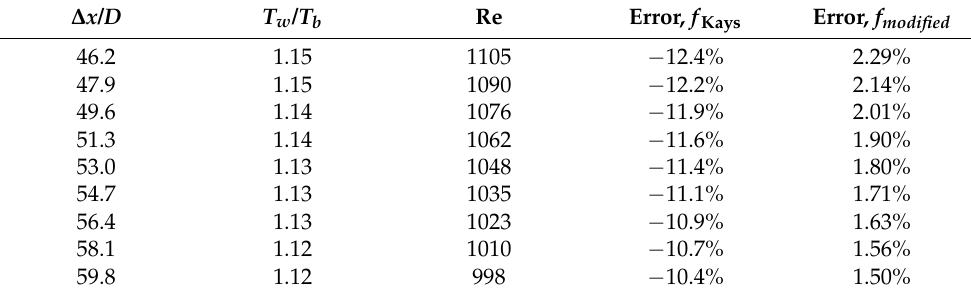
Table 12. Calculation error of modified f correlation for HeXe28.3 with case